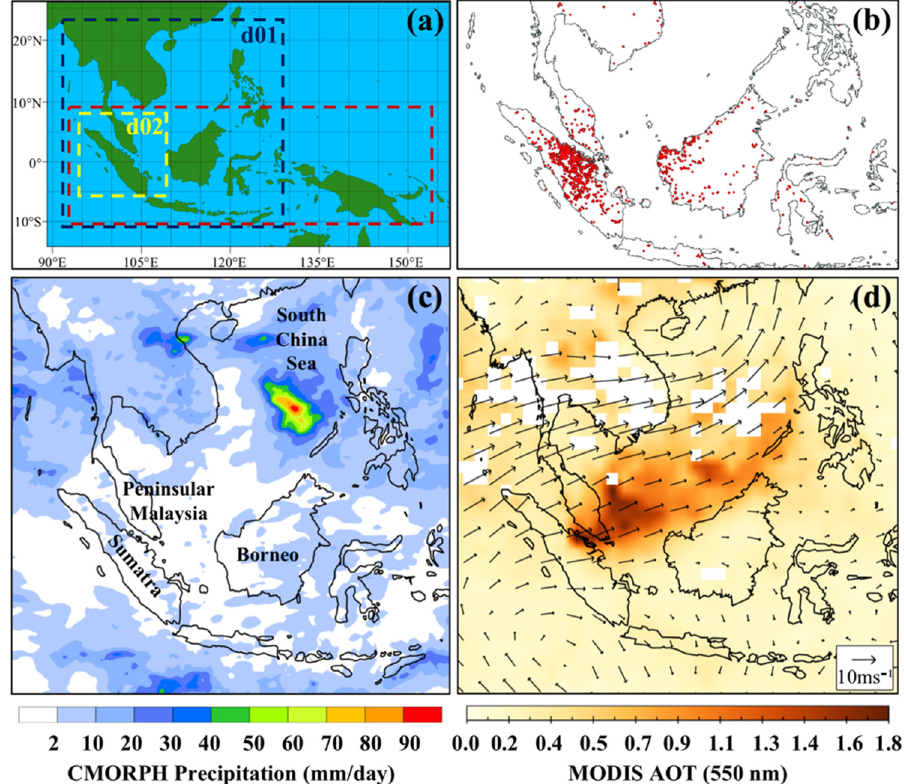
Figure 2. Overview of the aerosol and meteorological environment over the study region from 17 to 25 June 2013. ( a ) WRF-Chem model domain (dark blue) and nest d02 (yellow), and the Maritime Continent (MC) (red). ( b ) MODIS Terra and Aqua active fire hotspot detections (red dots). ( c ) Climate Prediction Center MORPHing technique product (CMORPH) average daily precipitation. ( d ) MODIS aerosol optical thickness (AOT) at 550 nm overlaid by average surface winds from the WRF-Chem simulations used in this study.